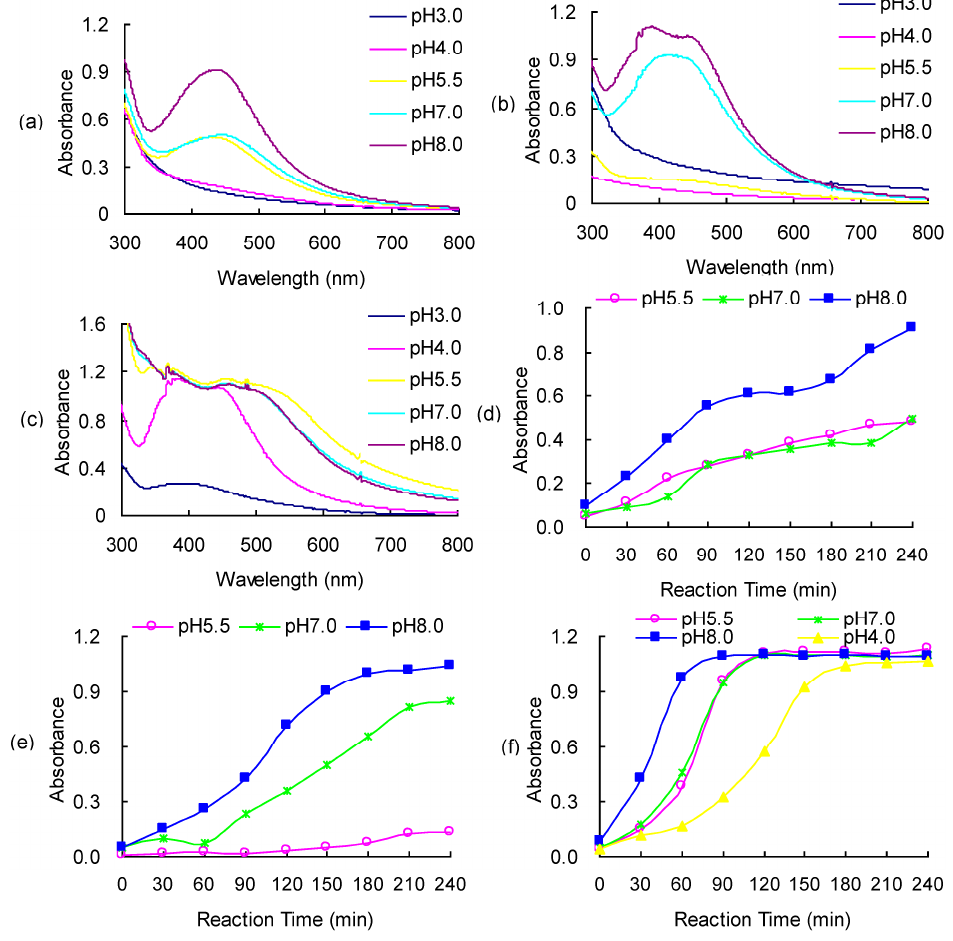
Figure 1. UV-Vis absorbance spectra of AgNO 3 and ( a ) P 0.5 ; ( b ) P 2.0 ; ( c ) P 5.0 mixture reaction solution at various pH value after thermal treatment for 240 min; and peak absorbance at UV-Vis light absorbance spectra of AgNO 3 ; and ( d ) P 0.5 ; ( e ) P 2.0 ; ( f ) P 5.0 mixture reaction solution at various pH value for various periods of reaction